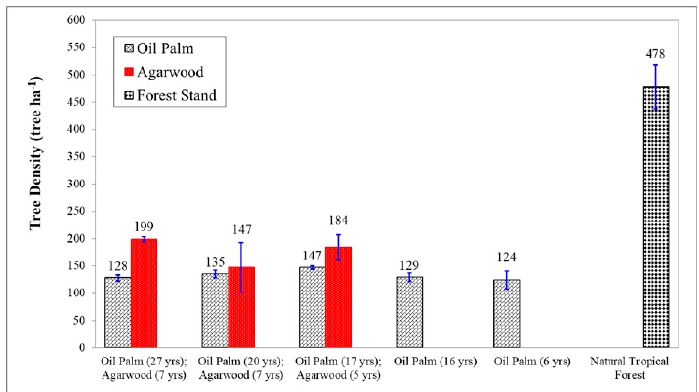
Note: Error bars showing mean ± standard error Figure 2. Tree density in different land use. Figure 2. Tree density in di ff erent land use.